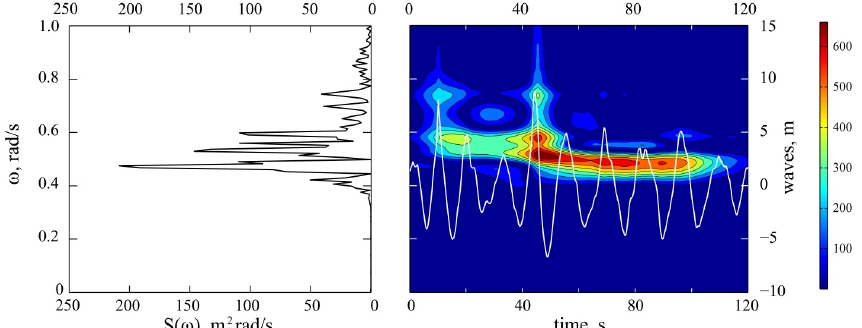
Figure 3. Time–frequency spectrum of group II between 440 and 520s.